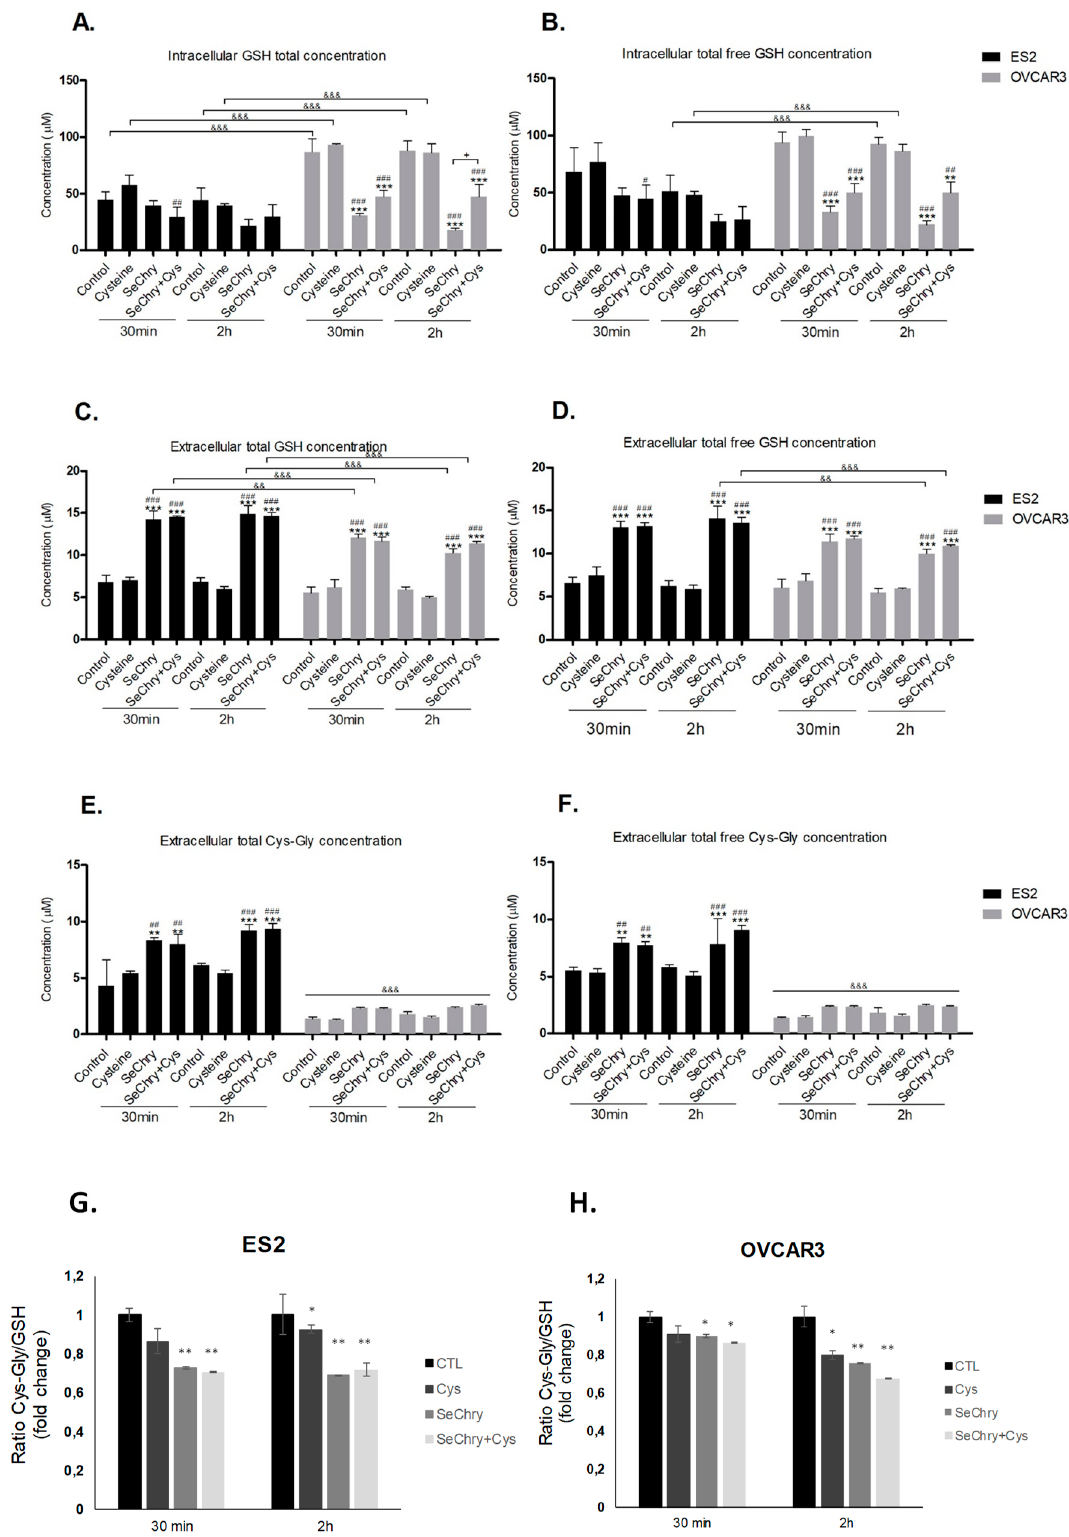
Figure 4. SeChry induces glutathione (GSH) turnover. ES2 and OVCAR3 cell lines were exposed to DMSO (control), cysteine, SeChry, and SeChry plus ( + ) cysteine; after 24 h of SeChry exposure, cells were incubated with cysteine for 30 min and 2 h. High-performance liquid chromatography (HPLC) coupled to fluorescence detection was used to measure ( A ) intracellular total GSH concentration, ( B ) intracellular total free GSH concentration, ( C ) total GSH concentration in the supernatant, ( D ) total free GSH concentration in the supernatant, ( E ) total cysteinyl-glycine (Cys-Gly) concentration in